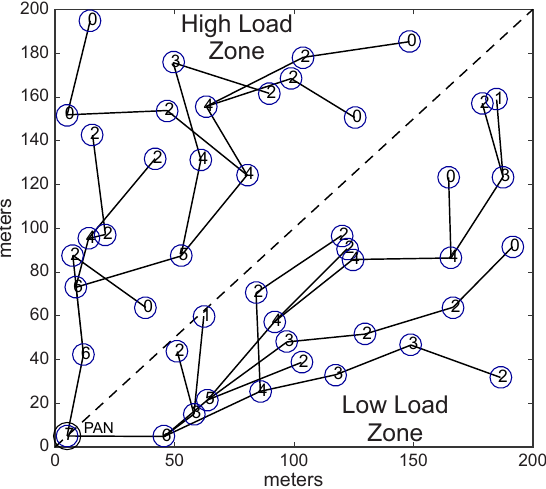
Figure 25. An example of Superframe Order configuration for all cluster-heads, using Nodes-SDA scheme (conditioned